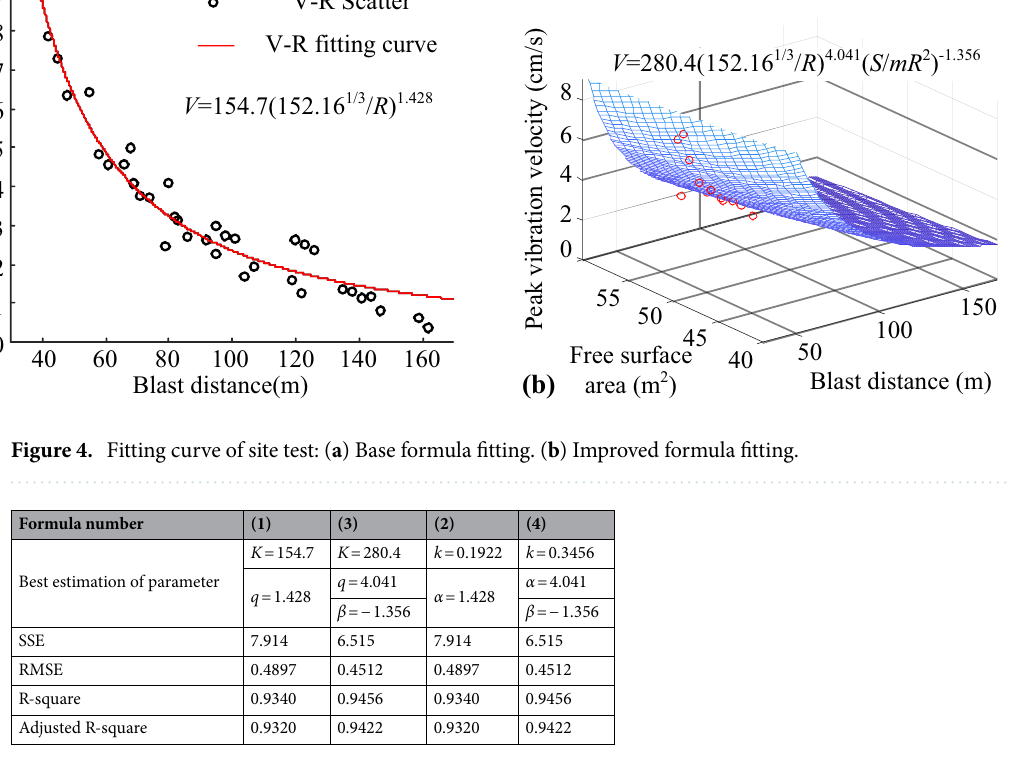
Table 3. Field test fitting